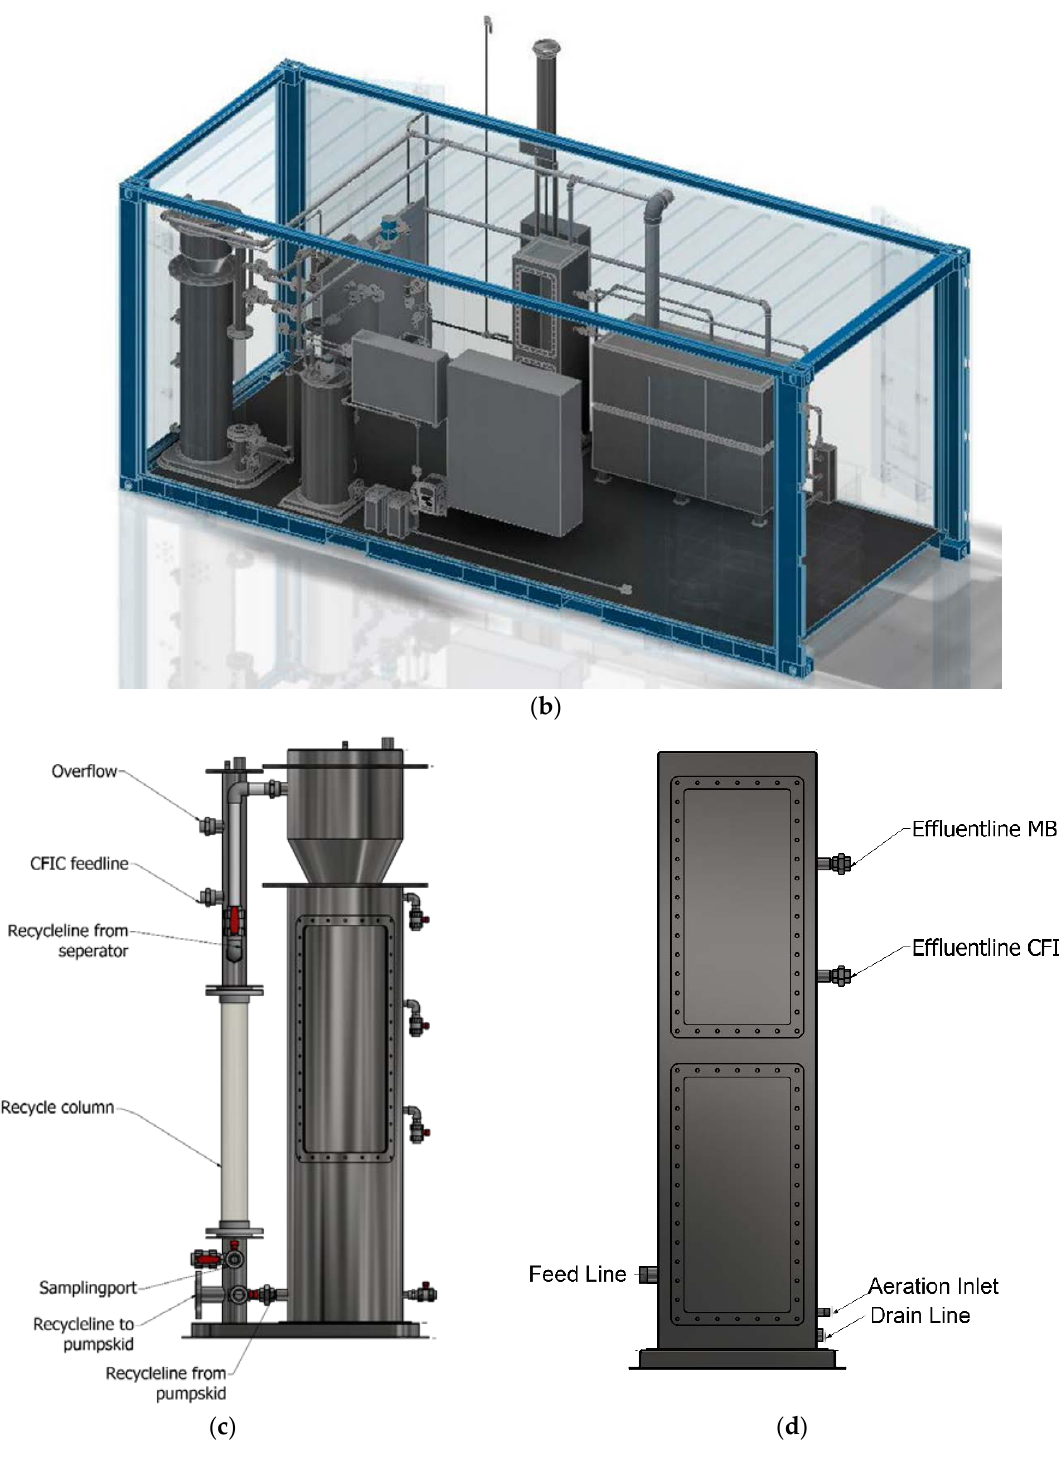
Figure 1. Drawings of the pilot units ( a ) Pilot units contents with wastewater and biogas flow direction marked; ( b ) overview of the 3D drawing. ( c ) EGSB unit layout. ( d ) CFIC reactor layout.